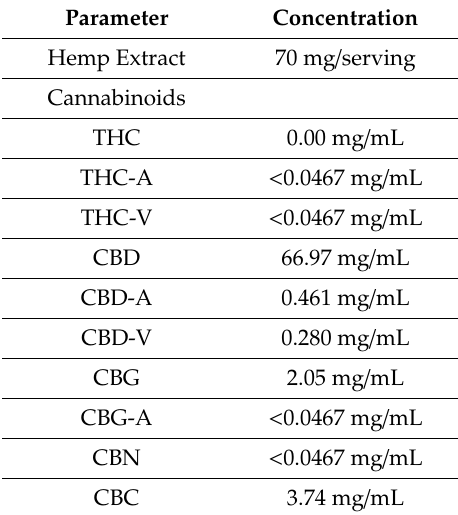
Table 2. Cannabinoid content in Charlotte’s Web Hemp Extract Oil Formula Olive Oil (according to Stanley Brothers Boulder